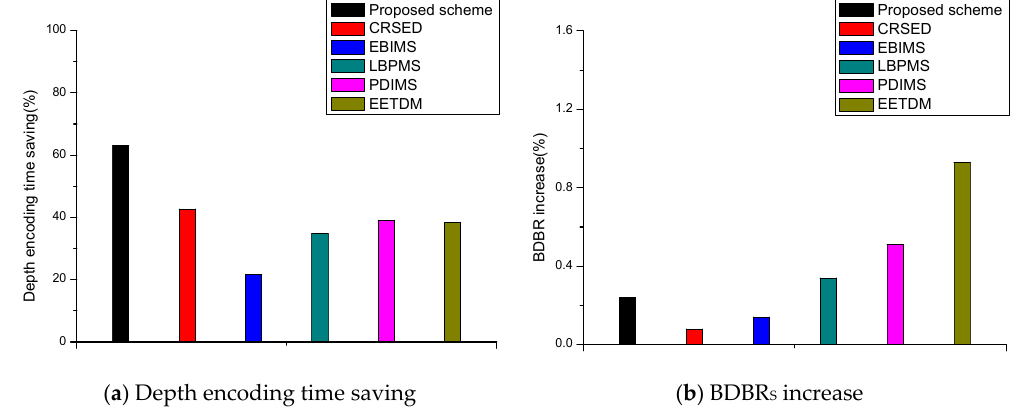
Figure 7. Coding results of the proposed scheme and five algorithms under the “All-Intra” configuration.